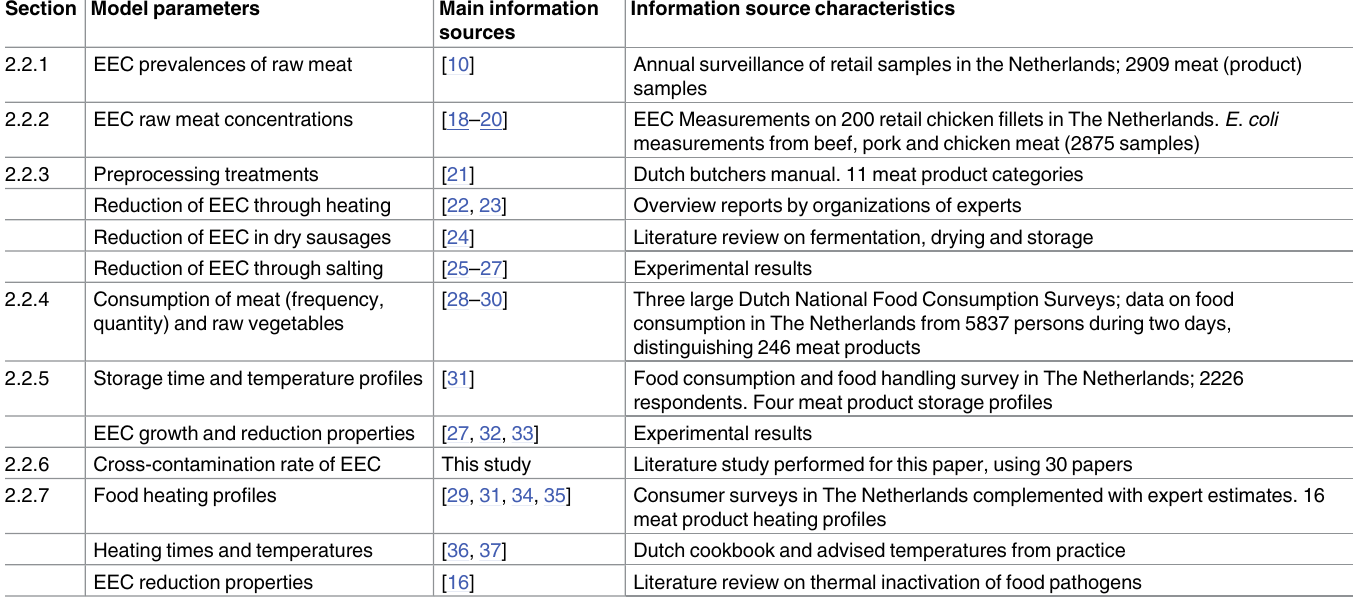
Table 1. Overview of information sources.